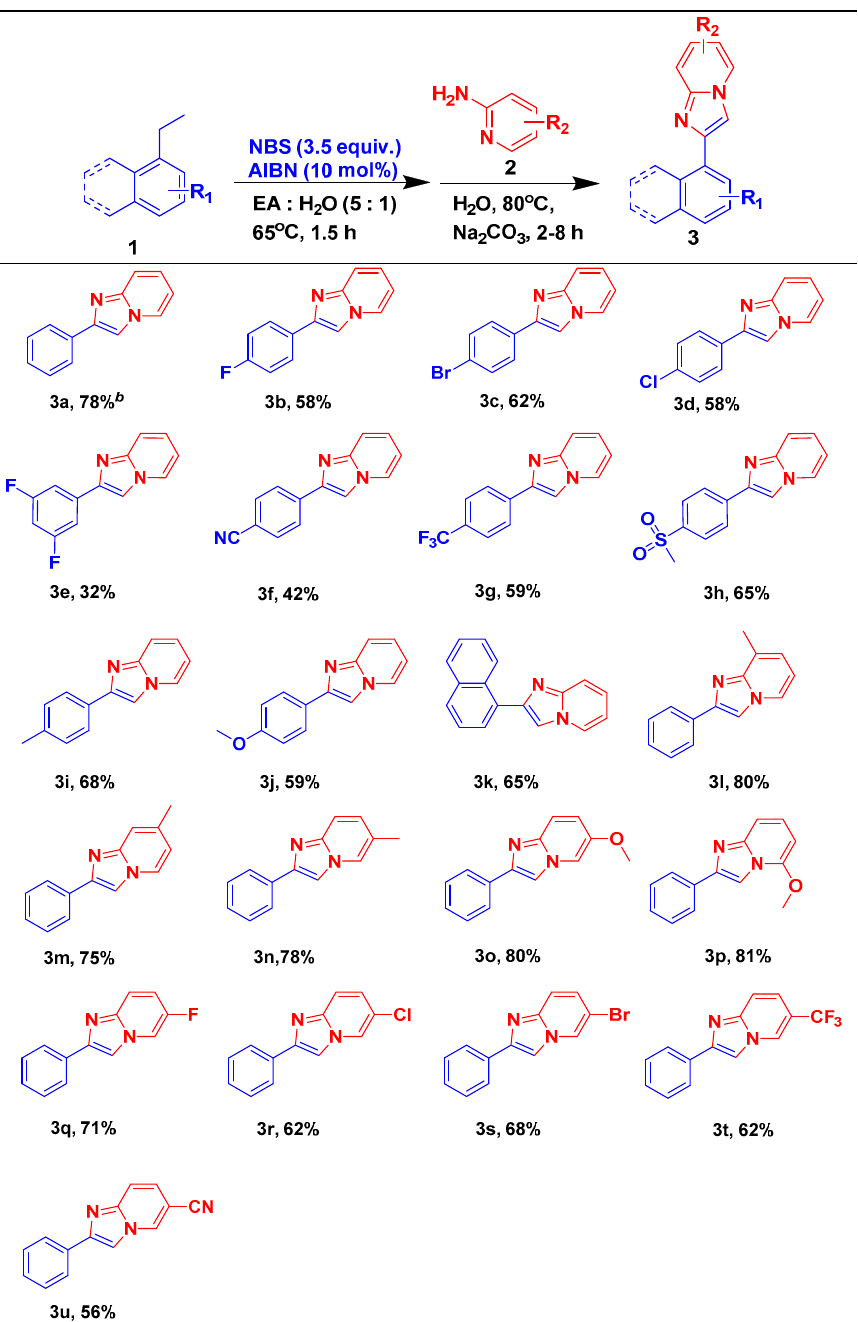
accelerates the intramolecular cyclization of the second step. Bringing the temperature to reflux did not have any noteworthy effect on the yield of 3a (Table 1, entry Table 2. Substrate scope for the imidazo[1,2-a]pyridines a .